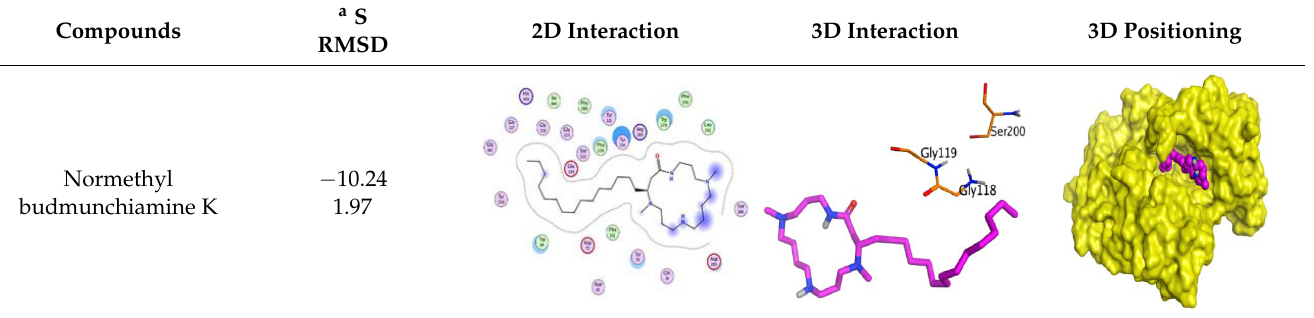
Table 4. Binding scores, RMSD, 3D binding interactions, and 3D positioning of the most promising alkaloids of A. lucidior inside the binding pocket of acetylcholinesterase, compared to donepezil and MF2 700 inhibitor.